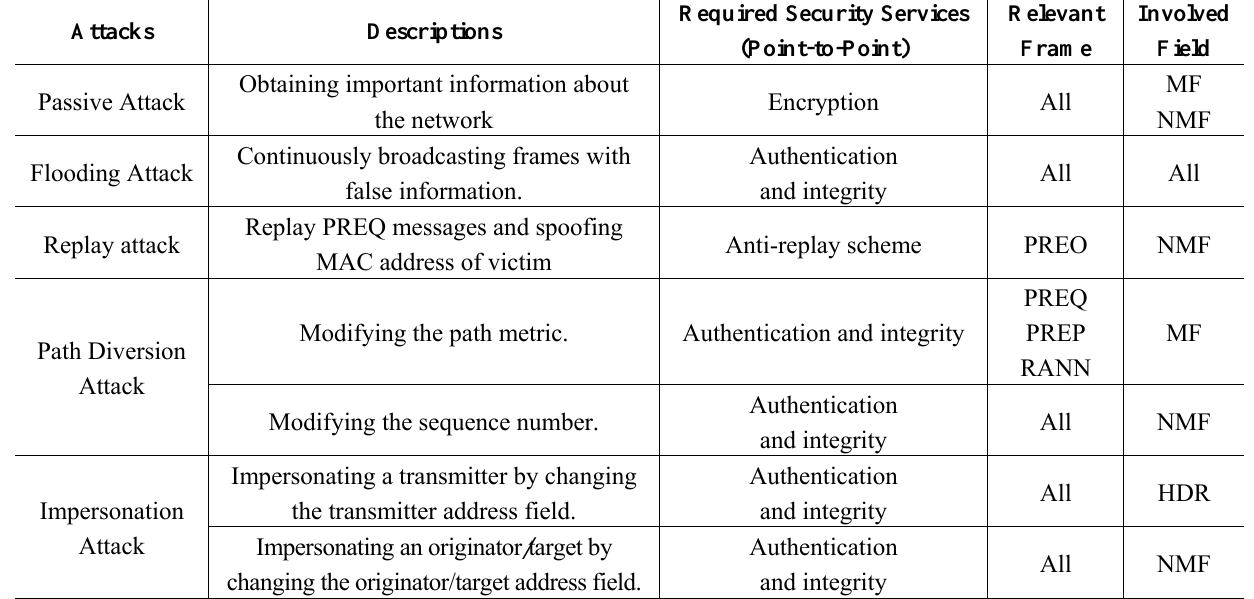
Table 7. External attacks, the required security services, and the relevant HWMP frames and fields